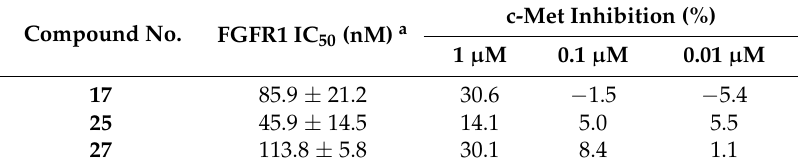
Table 5. FGFR1 and c-Met enzymatic activities of compounds 17 , 25 and 27 . Compound No.